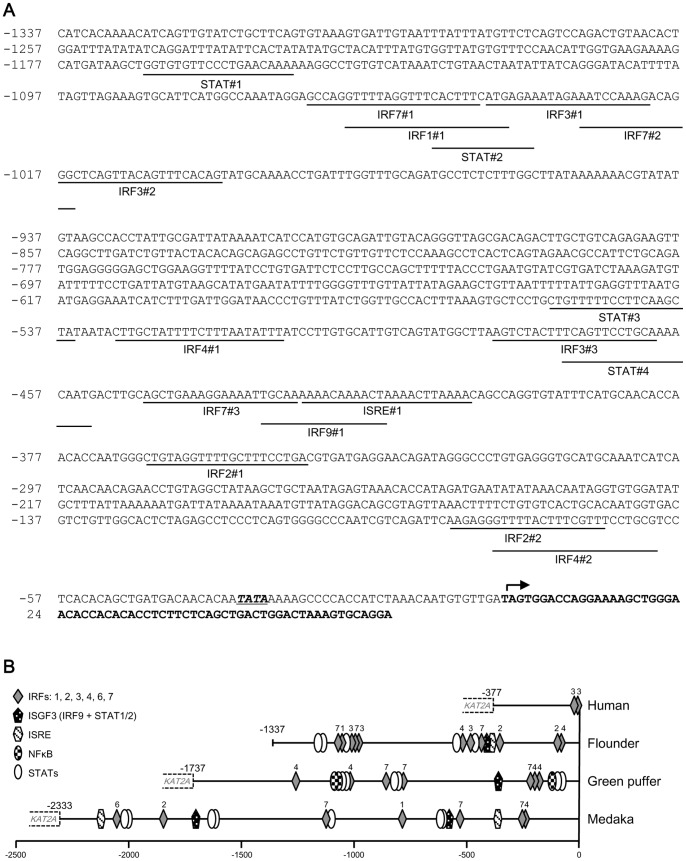
Potential transcription factor binding motifs in the 5′-upstream region of the olive flounder LGP2 gene.(A) Nucleotide sequence of the 5′-upstream region is shown with canonical motifs underlined. The transcription initiation site is indicated by an arrow (±0). The TATA box motif is italicized and underlined, and the coding region is in bold. (B) Comparison of the 5′-upstream region of the LGP2 gene in olive flounder (−1,337 to −1) with those of green puffer (Chr. 3∶13152455-13154190), Japanese medaka (Chr. 8∶6135706-6138037, complement), and humans (Chr. 17∶40264652-40265128, complement). The 5′-upstream region between LGP2 and KAT2A genes in humans, green puffer, and Japanese medaka was analyzed using MatInspector software (Genomatix). The schematic diagrams indicate transcription factor canonical motifs, and numbers on the diagrams indicate the types of IRFs.